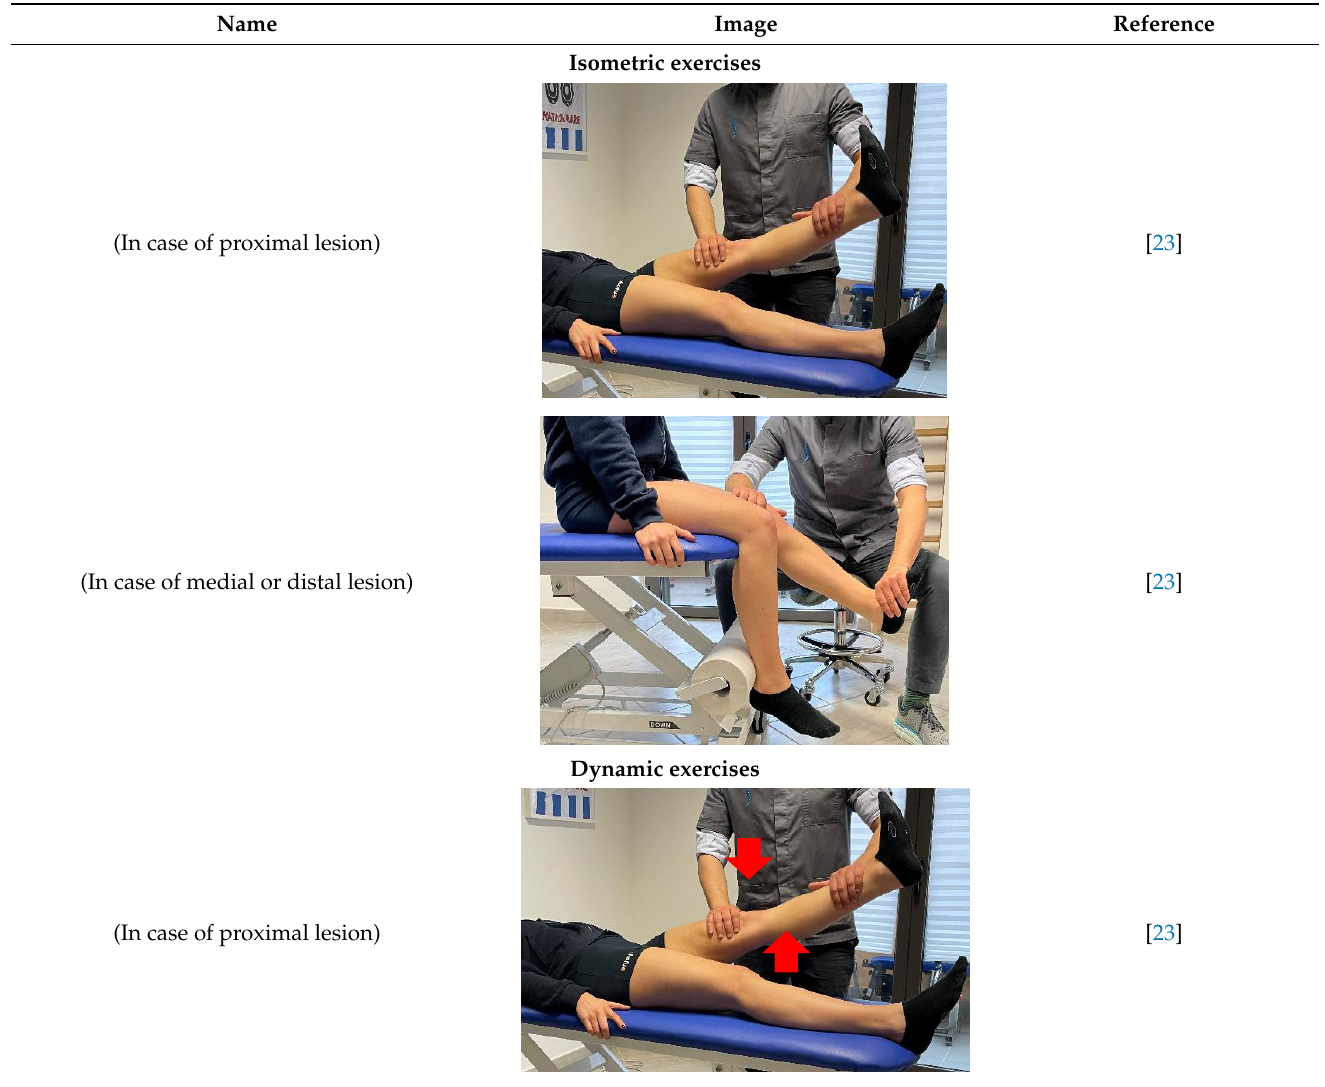
Table 3. Quadriceps rehabilitation exercises.